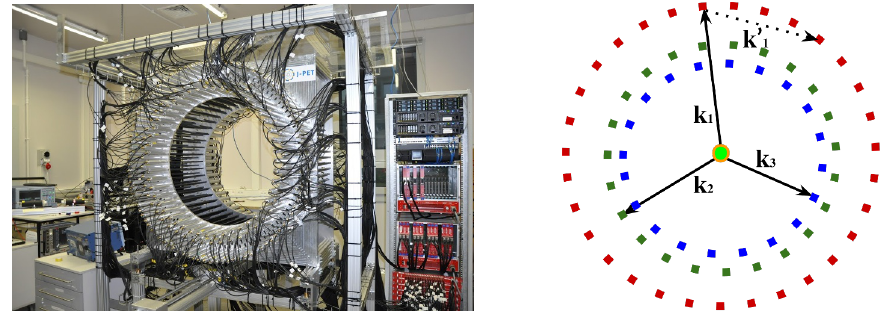
Figure 1. (Left) Front view of the J-PET detector. (Right) Schematic view of the J-PET detector with three distinguishable layers of scintillators at blue, green and red concentric cylinders. A positron source (green) is placed in the center, covered with XAD-4 porous polymer (orange). The superimposed arrows indicate the annihilation photons from ortho-Positronium decay ( k i , k j and k k ), and scattered photon ( k (cid:48)